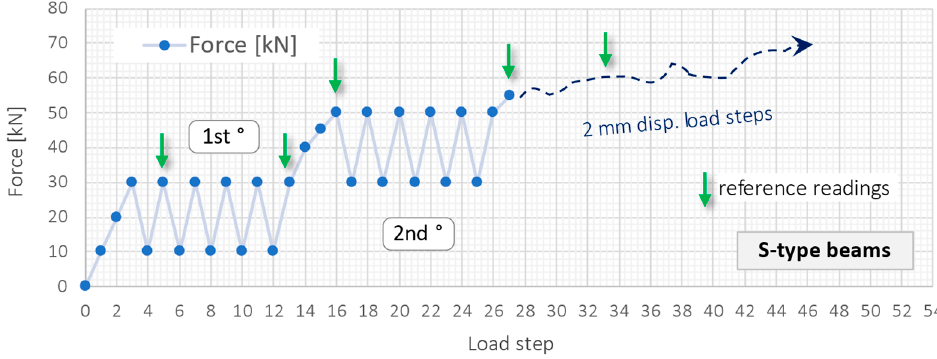
Figure 11. Designed research schedule for S-type